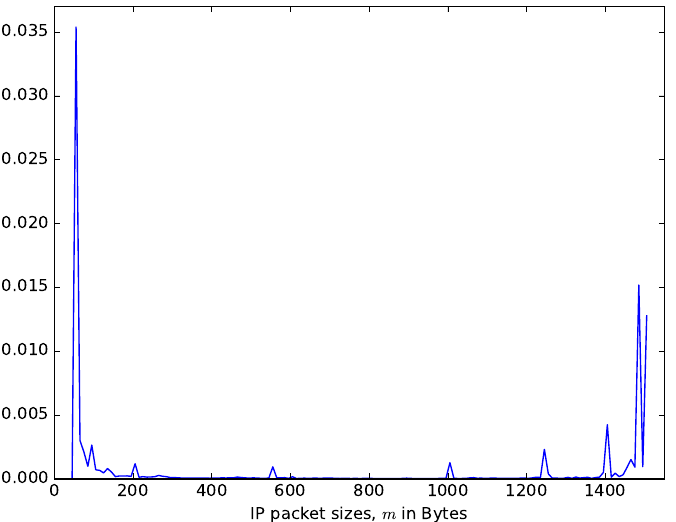
Figure 7. Distribution of the IP packet sizes, f M ( m ) from the CAIDA measurement of the Equinix Chicago